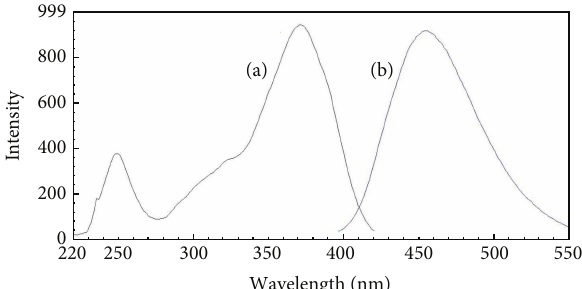
Figure 2: Excitation (a) and emission (b) spectra of the product of ammonium reacting with MOPA.